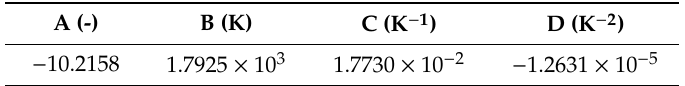
Table 4. Regression coe ffi cients for the dynamic viscosity of water. Reproduced from [30], Elsevier and Gulf Professional Publishing: 2010.